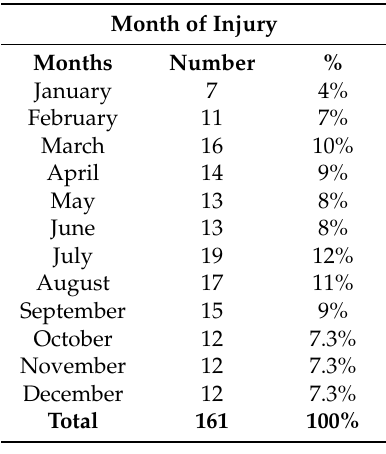
Table 2. Month of injury and number of percent of total annual